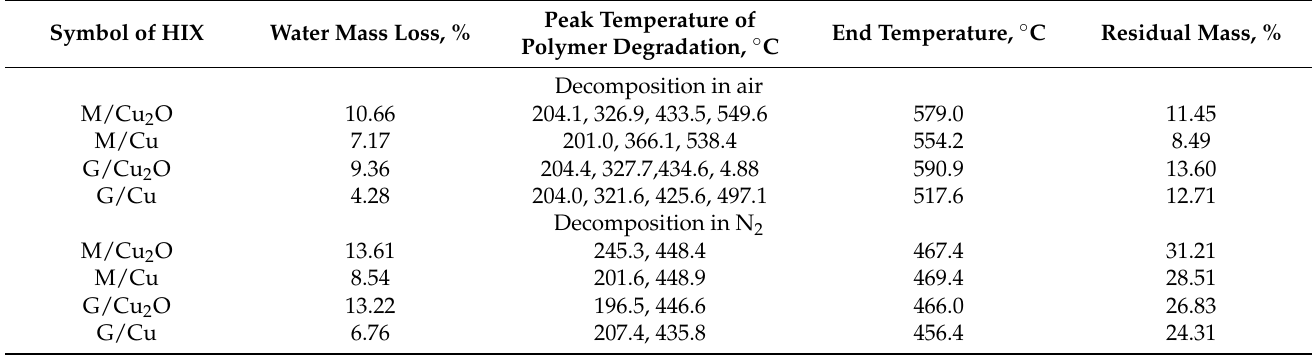
Figure 2. TG/DTG curves in air of ( a ) G/Cu 2 O, ( b ) G/Cu. Table 2. Statement of thermal decomposition